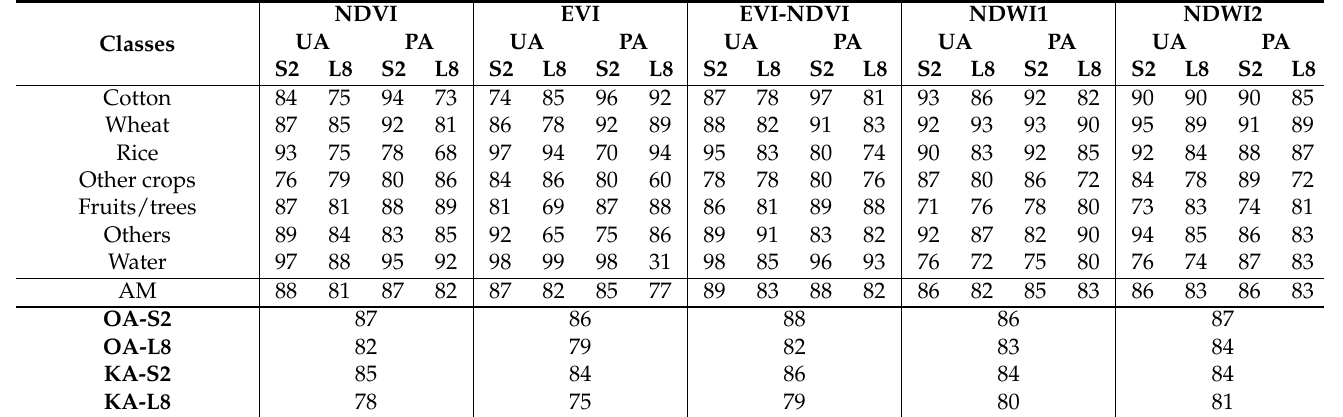
Table 5. Accuracy assessment (in %) results of SVM classifier.